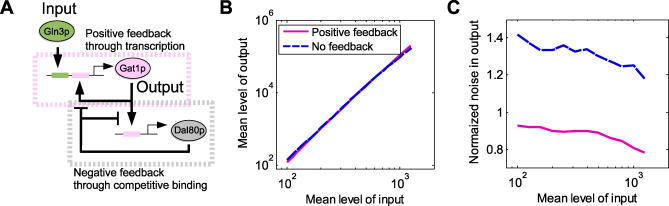
A Mechanism To Robustly Amplify a Signal and Average Noise(A) In the yeast nitrogen catabolite repression system, the transcription factor Gat1p is activated in response to Gln3p. It can then activate its own transcription, as well as DAL80, which binds to the same sequences as Gat1p and represses transcription.(B) The mean output (Gat1p) levels and its (C) noise content are shown for different input (nuclear Gln3p) levels. Simulation results are shown for the nitrogen system (pink line) and for a system with no feedback but with similar sensitivity (dashed blue line). The input noise level is η
0 = 1, and its autocorrelation time is τ
0 = 2 units. The other time constants are τ
1 = τ
2 =10 units. Dal80p binds its own promoter with a Hill coefficient of 2, whereas all other Hill coefficients equal 1.